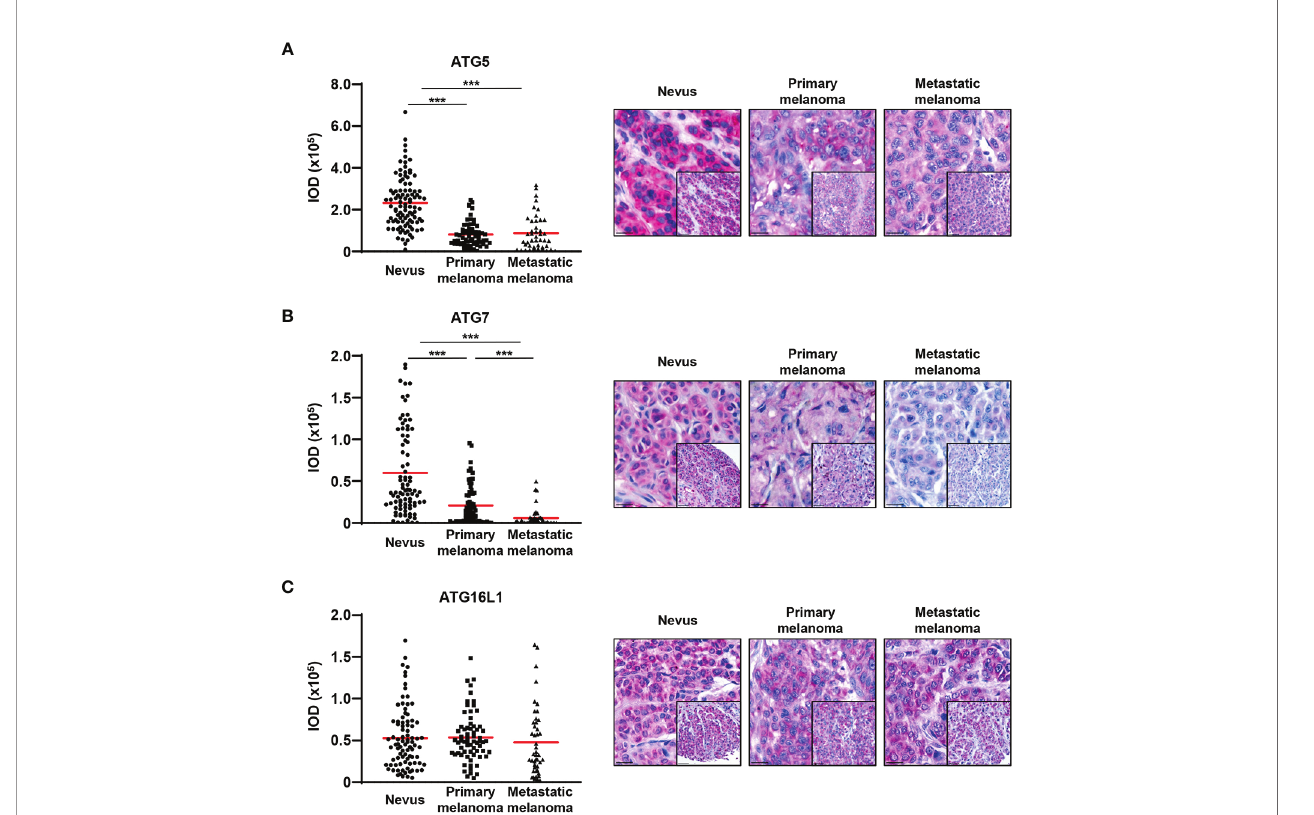
FIGURE 1 | ATG5 and ATG7 levels are decreased in primary and metastatic melanomas compared with benign nevi. (A – C) Immunohistochemistry. Quanti fi cation of the ATG5, ATG7, and ATG16L1 signal intensity. Intensity (integrated optical density (IOD)) values for individual patients are presented. The red lines represent the mean of all values. Statistical differences were analysed by one-way ANOVA using a Kruskal-Wallis test and Dunn ’ s post hoc test (left panel). p ≤ 0.001***. Representative images of 98, 89 and 88 benign nevi as well as 67, 69 and 67 primary and 44, 44 and 45 metastatic melanomas for ATG5, ATG7, and ATG16L1, respectively (right panel). Scale bars 20 m m (inlets) and 50 m